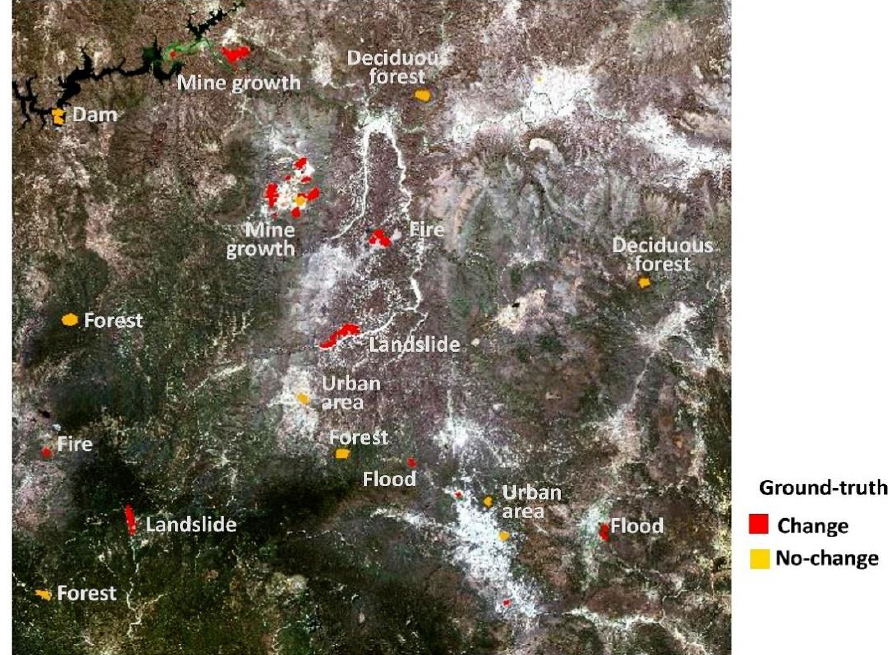
Figure 6. Spatial distribution of ground-truth polygons over the study area. The categories change (in red) and Non-change (in yellow) are shown during the 2011–2016 period.